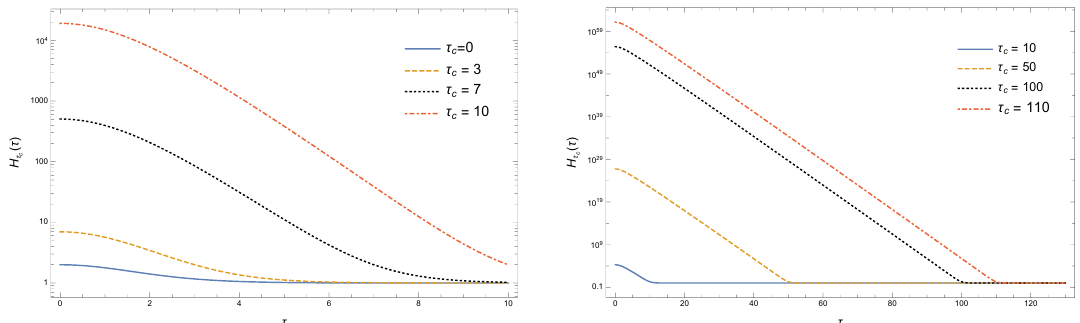
Figure 1 . Warp factor H ( τ ) (in log scale) for different choices of τ c . We can see how the choice of τ c is directly related to the strength of the warping and the size of the warped throat (defined as the region with non-trivial